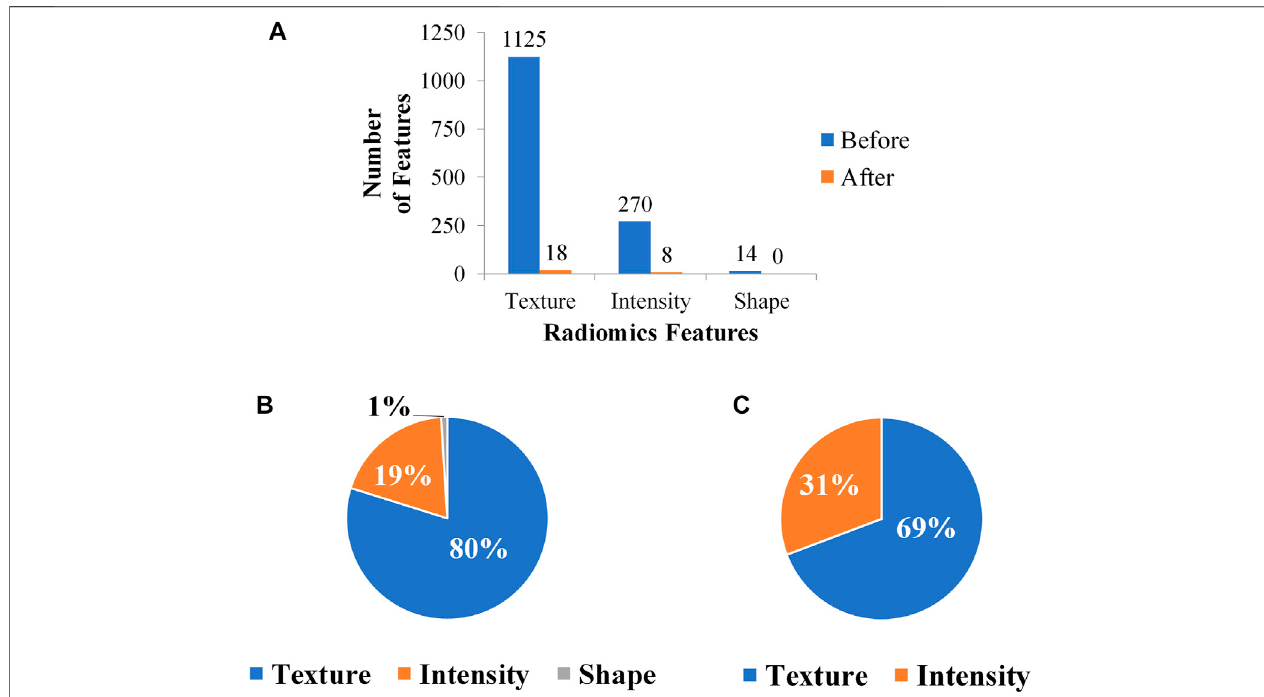
FIGURE 4 | Variation of feature number through feature selection. (A) Feature number before and after feature selection. (B) Feature ratio before feature selection. (C) Feature ratio after feature selection.